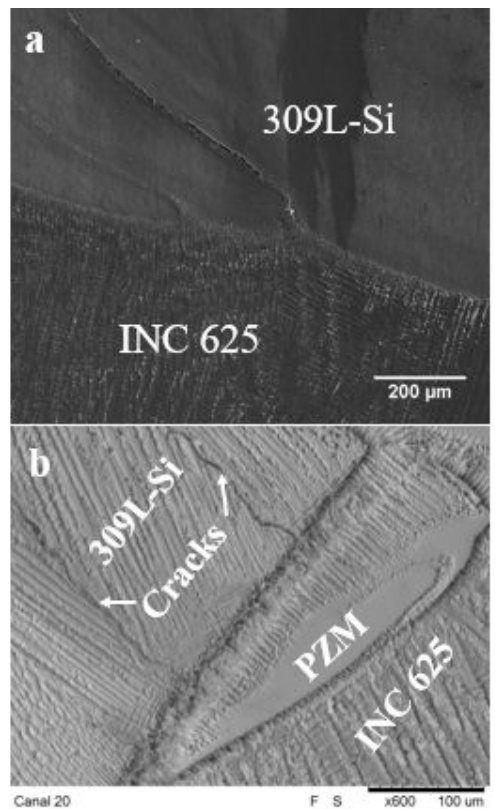
Figure 12. Solidification crack, a) on the 309L-Si weld metal, b) propagated crack starting on the